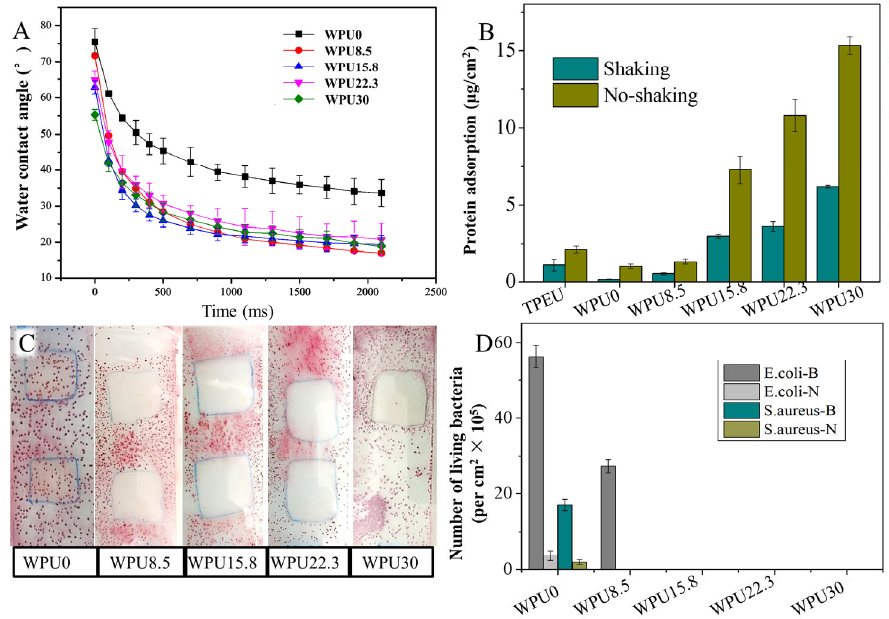
Figure 5. Anti-fouling activity of WPUn films. ( A ) Time-related water contact angle of WPUn films; ( B ) Nonspecific protein adsorption of WPUn films; ( C ) Contact-active antibacterial activity of WPUn films; ( D ) Number of living bacteria attached on WPUn under different bacterial culture ( E. coli -LB+: LB + 0.5% vcasamino acids; E. coli -LB: LB; S. aureus -TSB+: (TSB + 2% glucose; S. aureus -TSB: TSB).